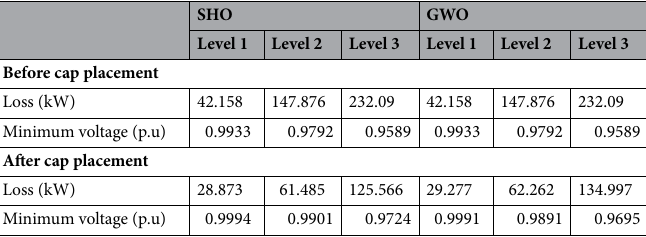
Table 12. Losses and minimum load voltage before and after the capacitor placement in the scenario of connected to the network with